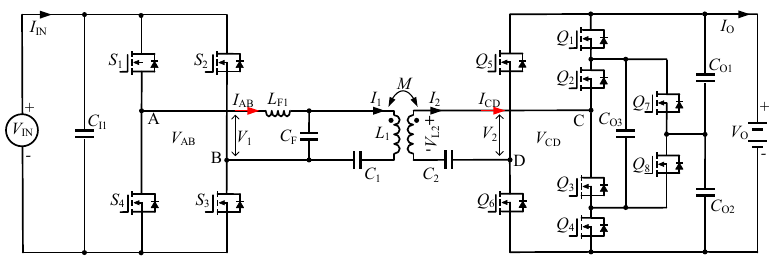
Figure 1. Circuit topology of the LCC/S-compensated IPT with TL rectifier.